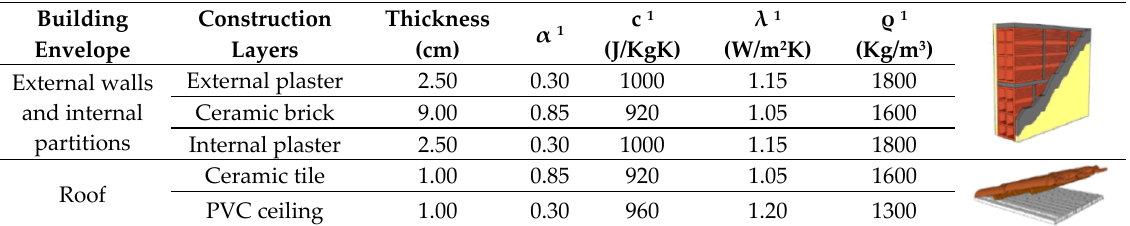
Figure 2. ( a ) Low-Income Housing, ( b ) Floor Plan and ( c ) Sections plans. Table 2. Thermal and physical properties of the building materials. Source: ABNT NBR 15.220